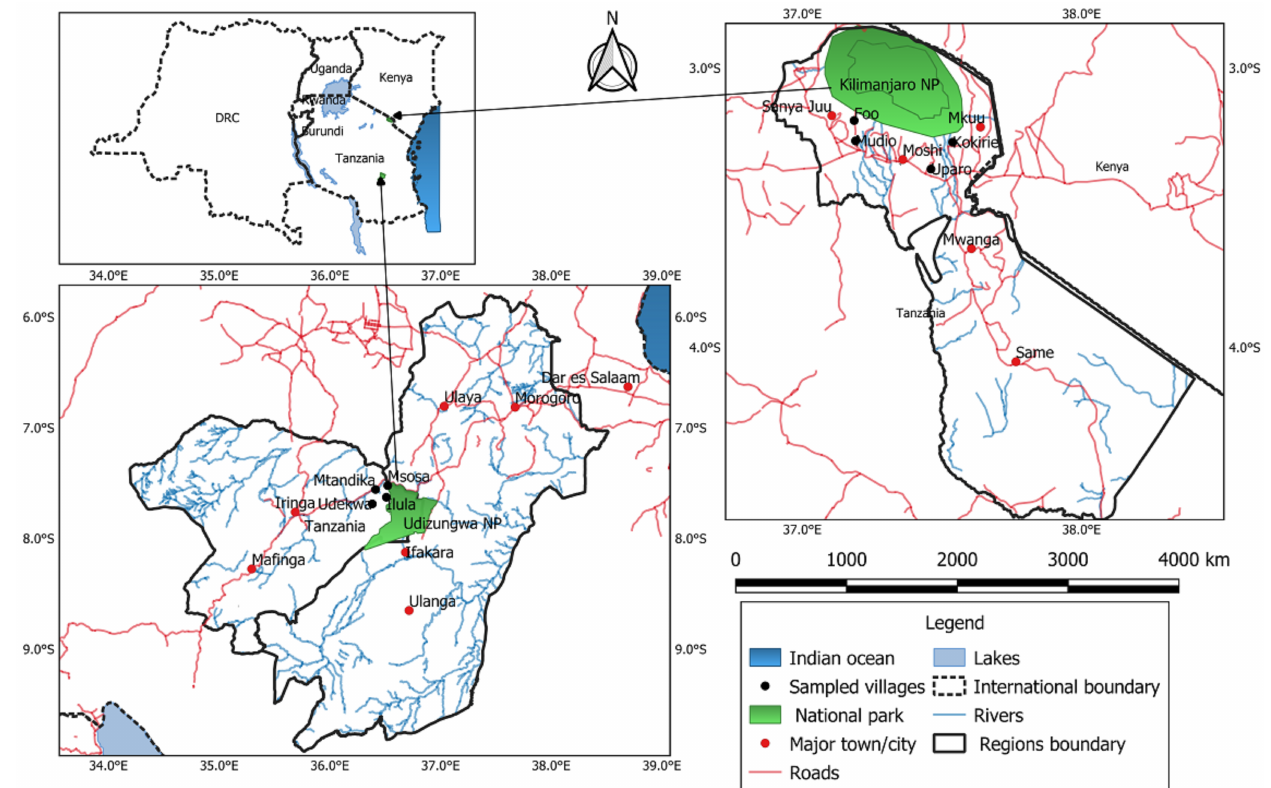
Figure 1. Map of Tanzania (top left inset) showing the locations of the two national parks. The sampled villages for Udzungwa are situated in the Rufiji River Basin, while sampled villages for Mount Kilimanjaro are situated in the Pangani River Basin. In each study site, four villages were sampled. Villages sampled in the Udzungwa Mountains were Udekwa (1013 m asl; 7 ◦ 41’14.64”S 36 ◦ 23’1.68”E), Mtandika (570 m asl; 7 ◦ 33’19.08”S 36 ◦ 23’48.48”E), Msosa (596 m asl; 7 ◦